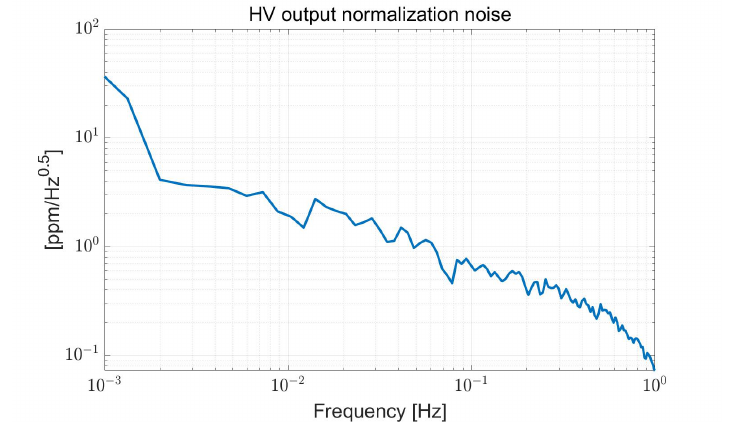
Figure 6. The normalization noise of HV output.